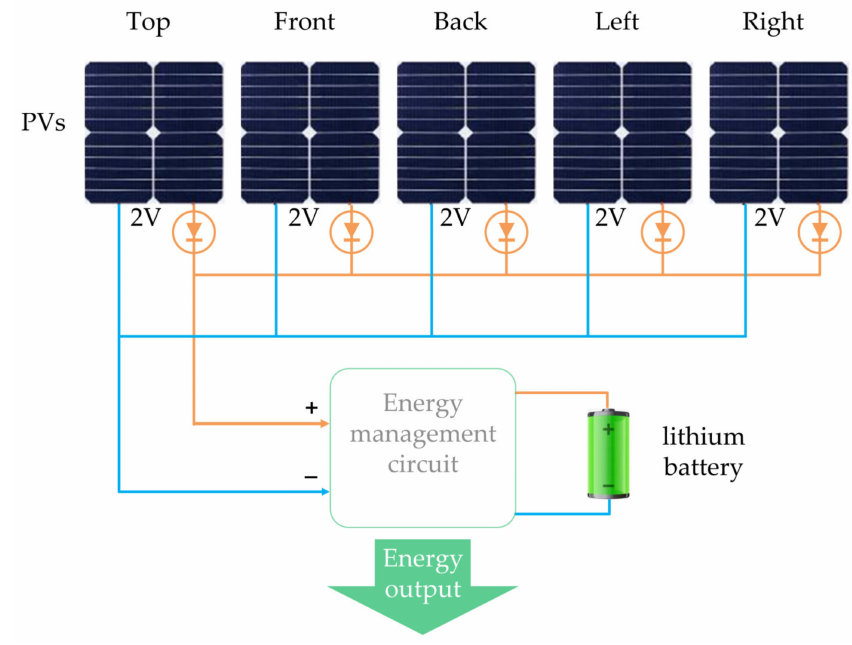
Figure 4. Self-powered module of